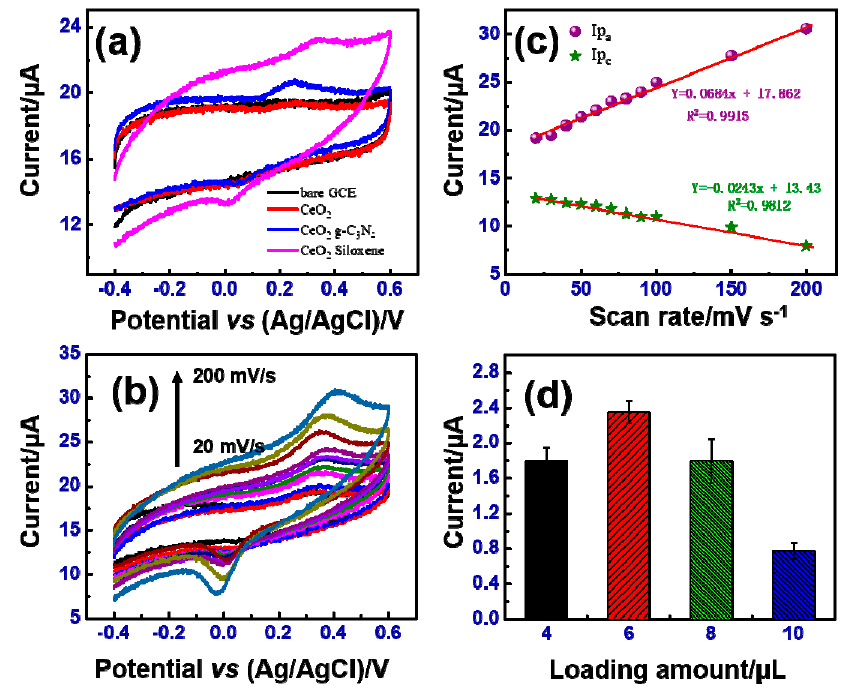
Figure 6. ( a ) Cyclic voltammetry response of bare glassy carbon electrodes (GCEs) and